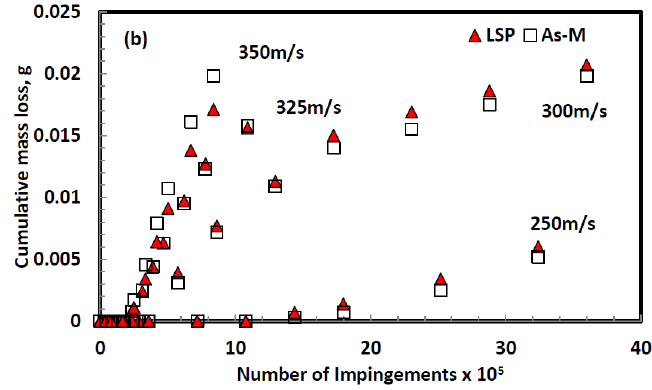
Figure 10. WDE curves for As ‐ M versus LSP at ( a ) 150–200 m/s and ( b ) 250–350 m/s.